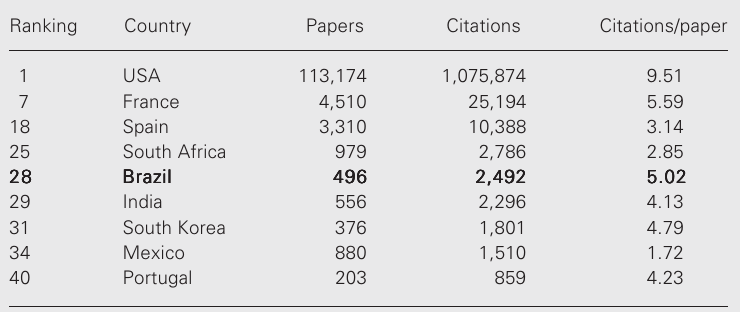
Table 5. Number of papers and citations at the Psychology/Psychiatry Journal of Citation Report site a from 1998 to